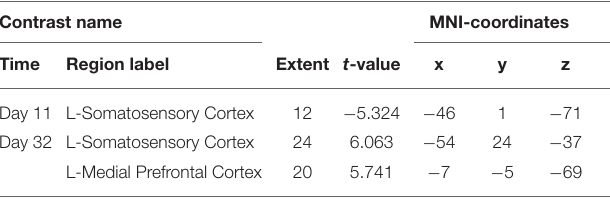
TABLE 1 | Results of amplitude of low-frequency fluctuations (ALFF) analysis.